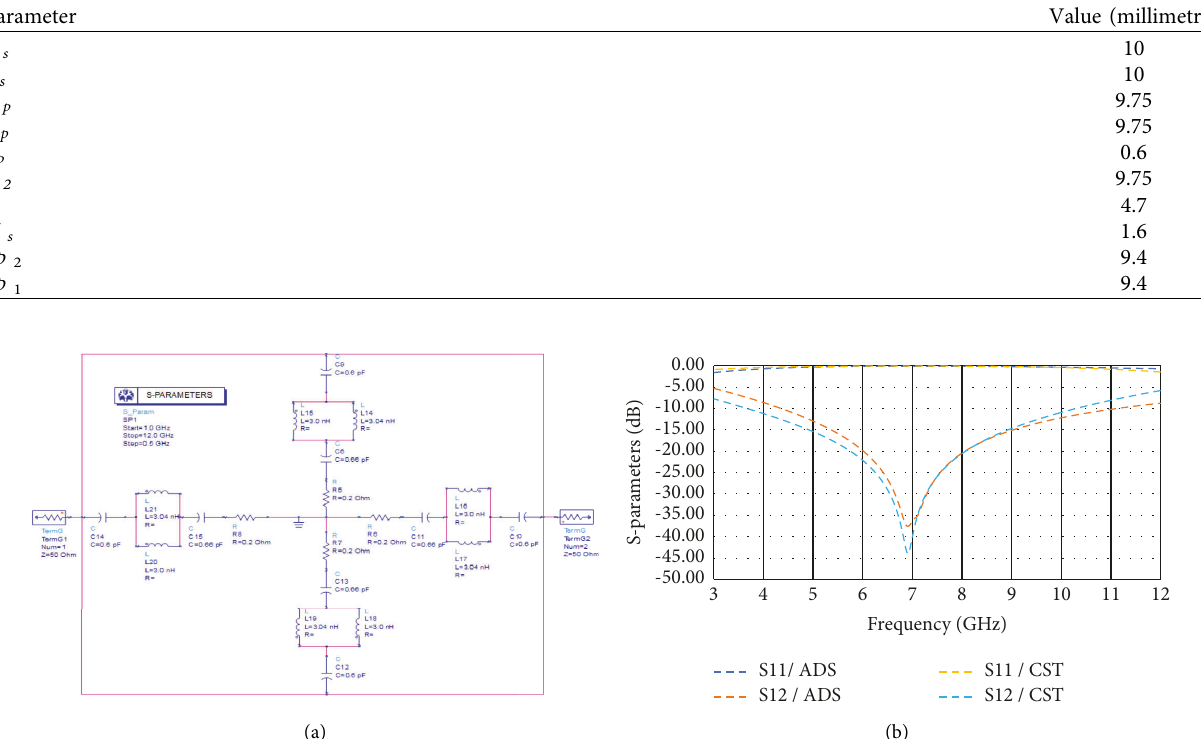
Figure 5: (a) EC associated with unit cell. (b) Transmission coefficient of unit